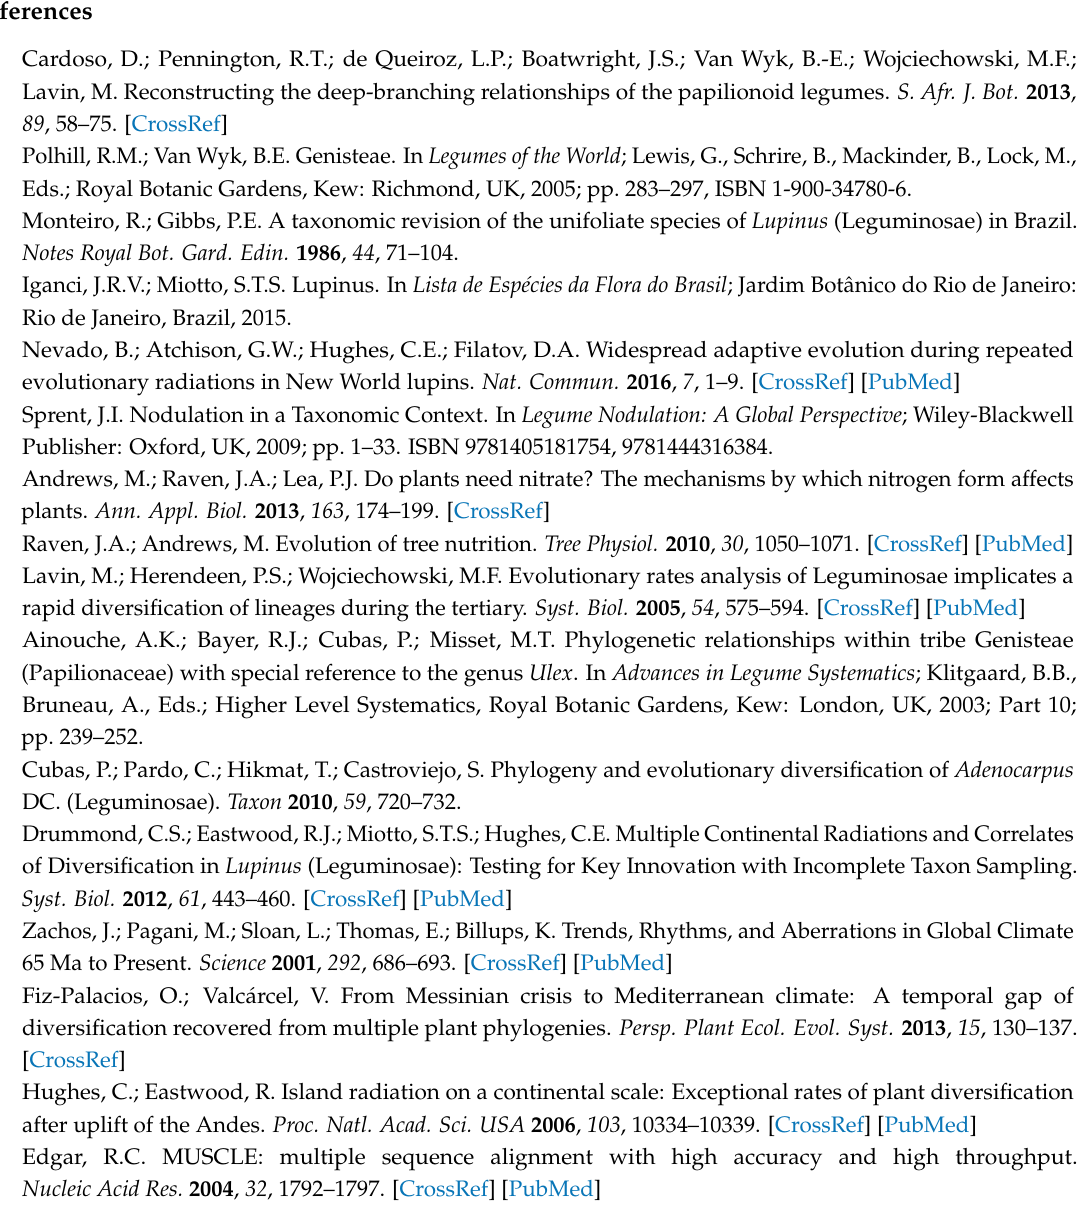
Figure S1: ML phylogeny of Bradzrhyiobium glnII gene; Figure S2: ML phylogeny of Bradzrhyiobium recA gene; Figure S3: ML phylogeny of Bradzrhyiobium nodA gene; Figure S4: The portion of nifD ML phylogenetic tree referring to Bradyrhizobium Clade II branch; Table S1: The list of Bradyrhizobium species; Table S2: The list of Legume genera belonging to nifD gene Clades that comprise Genisteae Bradyrhizobium symbionts. Acknowledgments: This work was supported by a grant UMO-2014/15/B/NZ8/00259 (T.S.&J.B.) from The National Science Centre